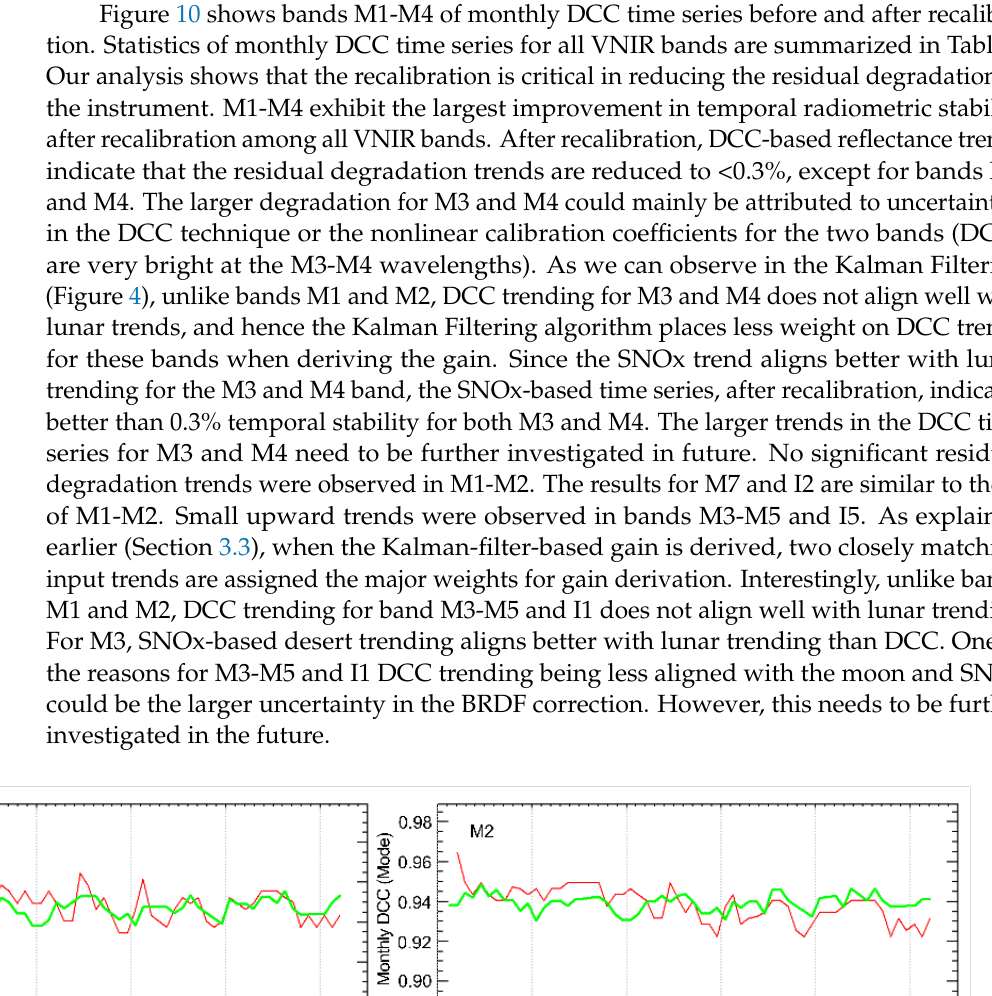
Figure 11. Suomi NPP VIIRS bands’ M8–M11 monthly DCC reflectance time series before (red color, operational) and after (green color) recalibration. Table 4. Statistics of monthly DCC time series for the operational and reprocessed Suomi NPP VIIRS RSBs, including averaged monthly DCC reflectance (Avg.), standard deviation (SD,%), and linear trends (%/year). Monthly DCC Reflectance (Operational) Monthly DCC Reflectance (Reprocessed) Avg.